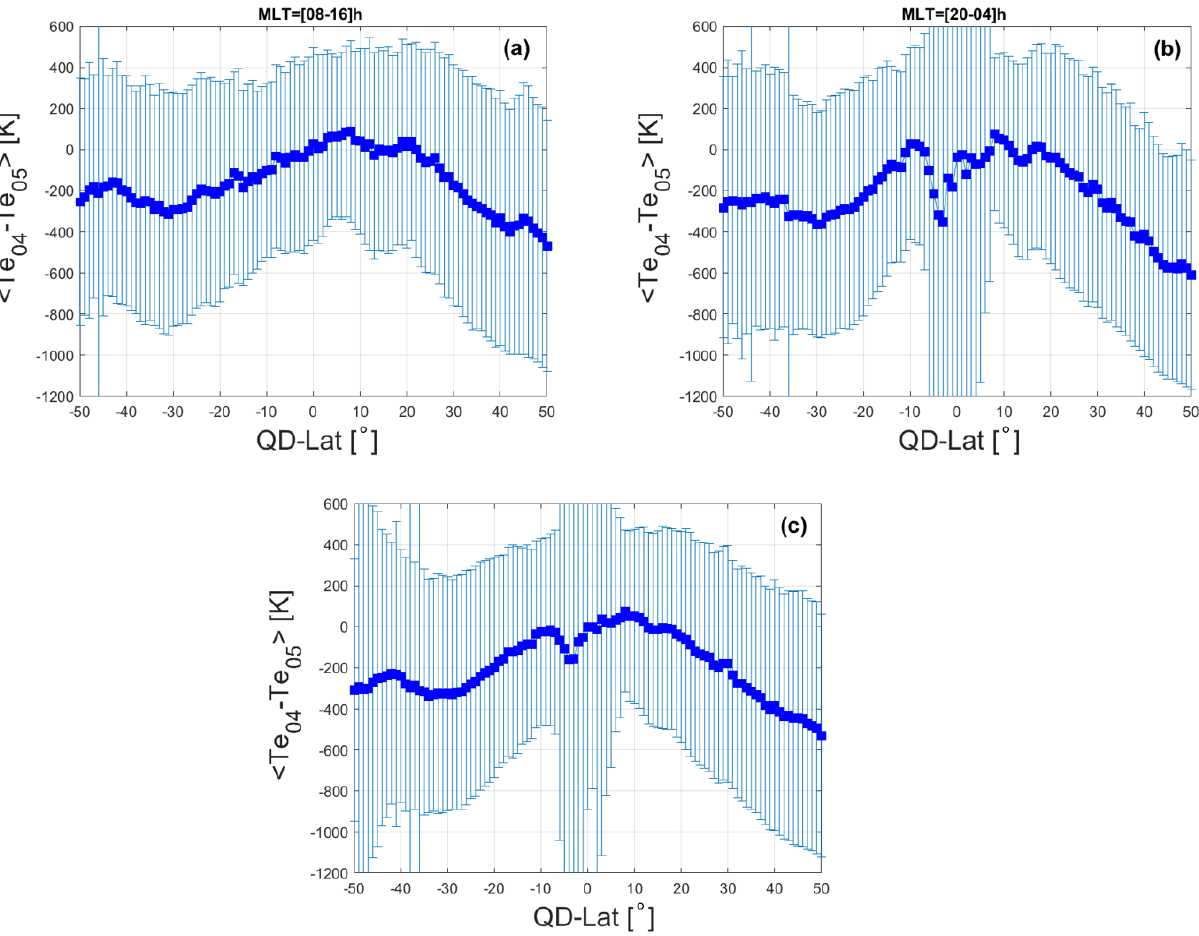
Figure 3. Difference between electron temperature T e computed from baseline 04 ( T e measured by Swarm A from 7 to 13 September 2018. Blue squares are the daily averages of each 1 ◦ bin in latitude, while vertical bars represent the standard deviation. The figure shows the difference during (a) day-side, (b) night-side, and (c) full